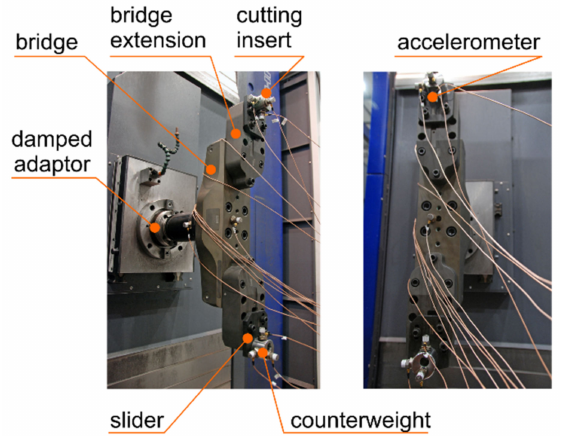
Figure 2. Boring tool views with attached accelerometers in the minimum extension of the damped adaptor